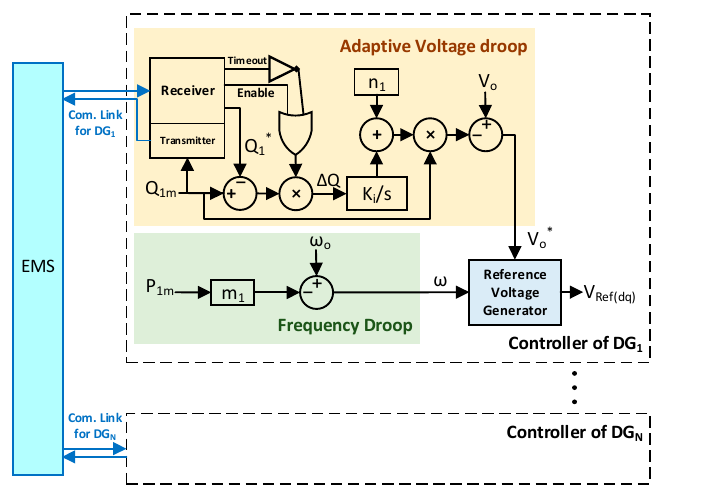
Figure 11. Block diagram of the controller of [106].